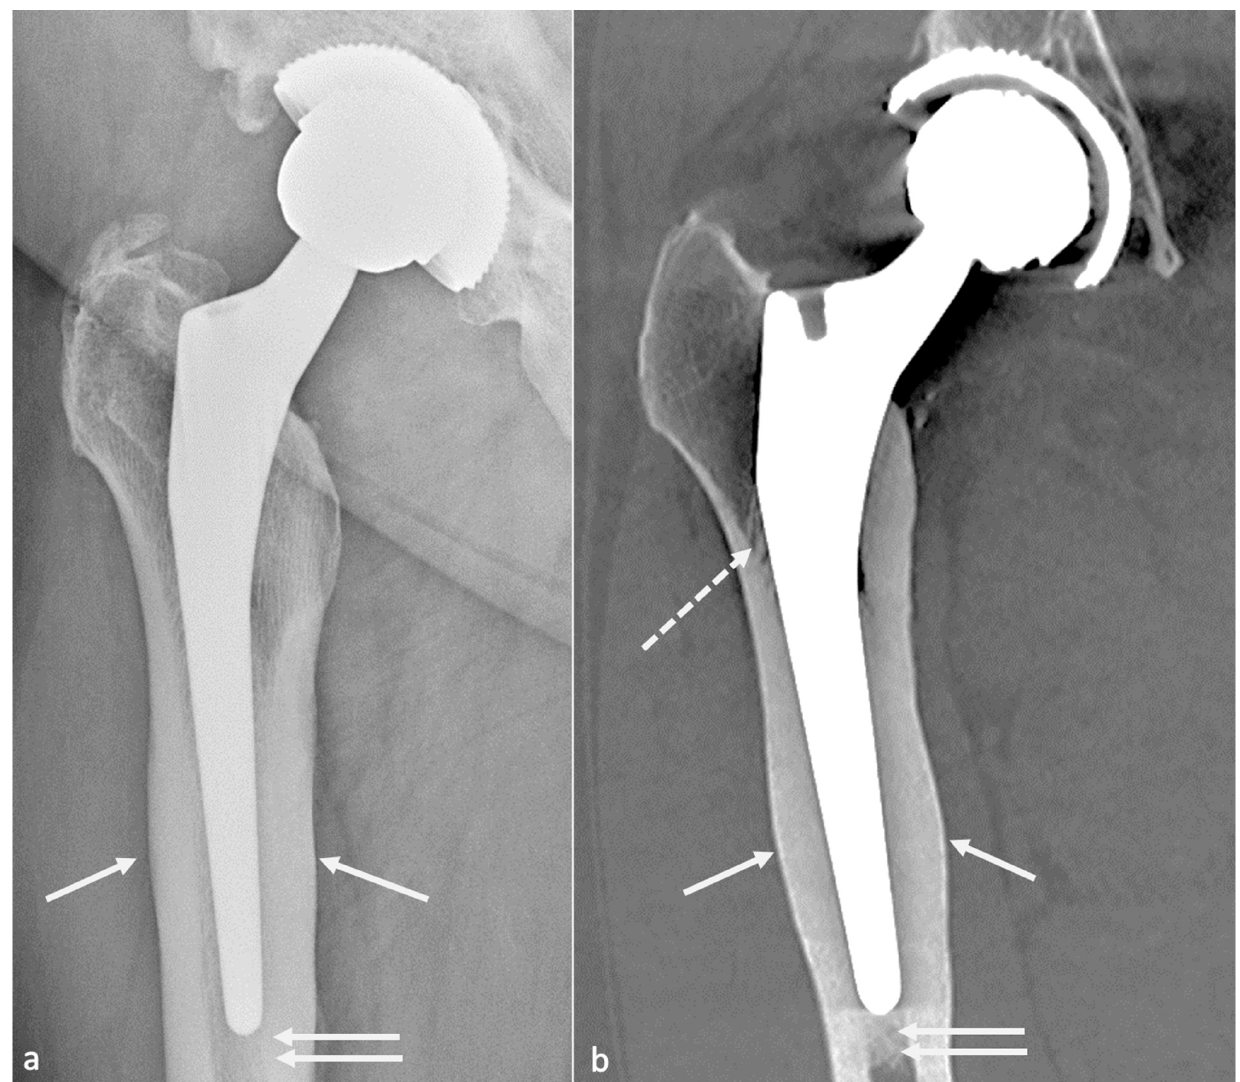
Figure 12. Successful fixation of an uncemented total hip arthroplasty. Regular and circumferen- tial cortical thickening (white arrow) and bony pedestal (double white arrow) are seen on ( a ) an anteroposterior hip view and ( b ) a coronal CT-scan slice. Additionally, note spot welds (white dotted arrow) better depicted on CT-scan, and the slight valgus position of the femoral stem, better depicted on the radiograph.